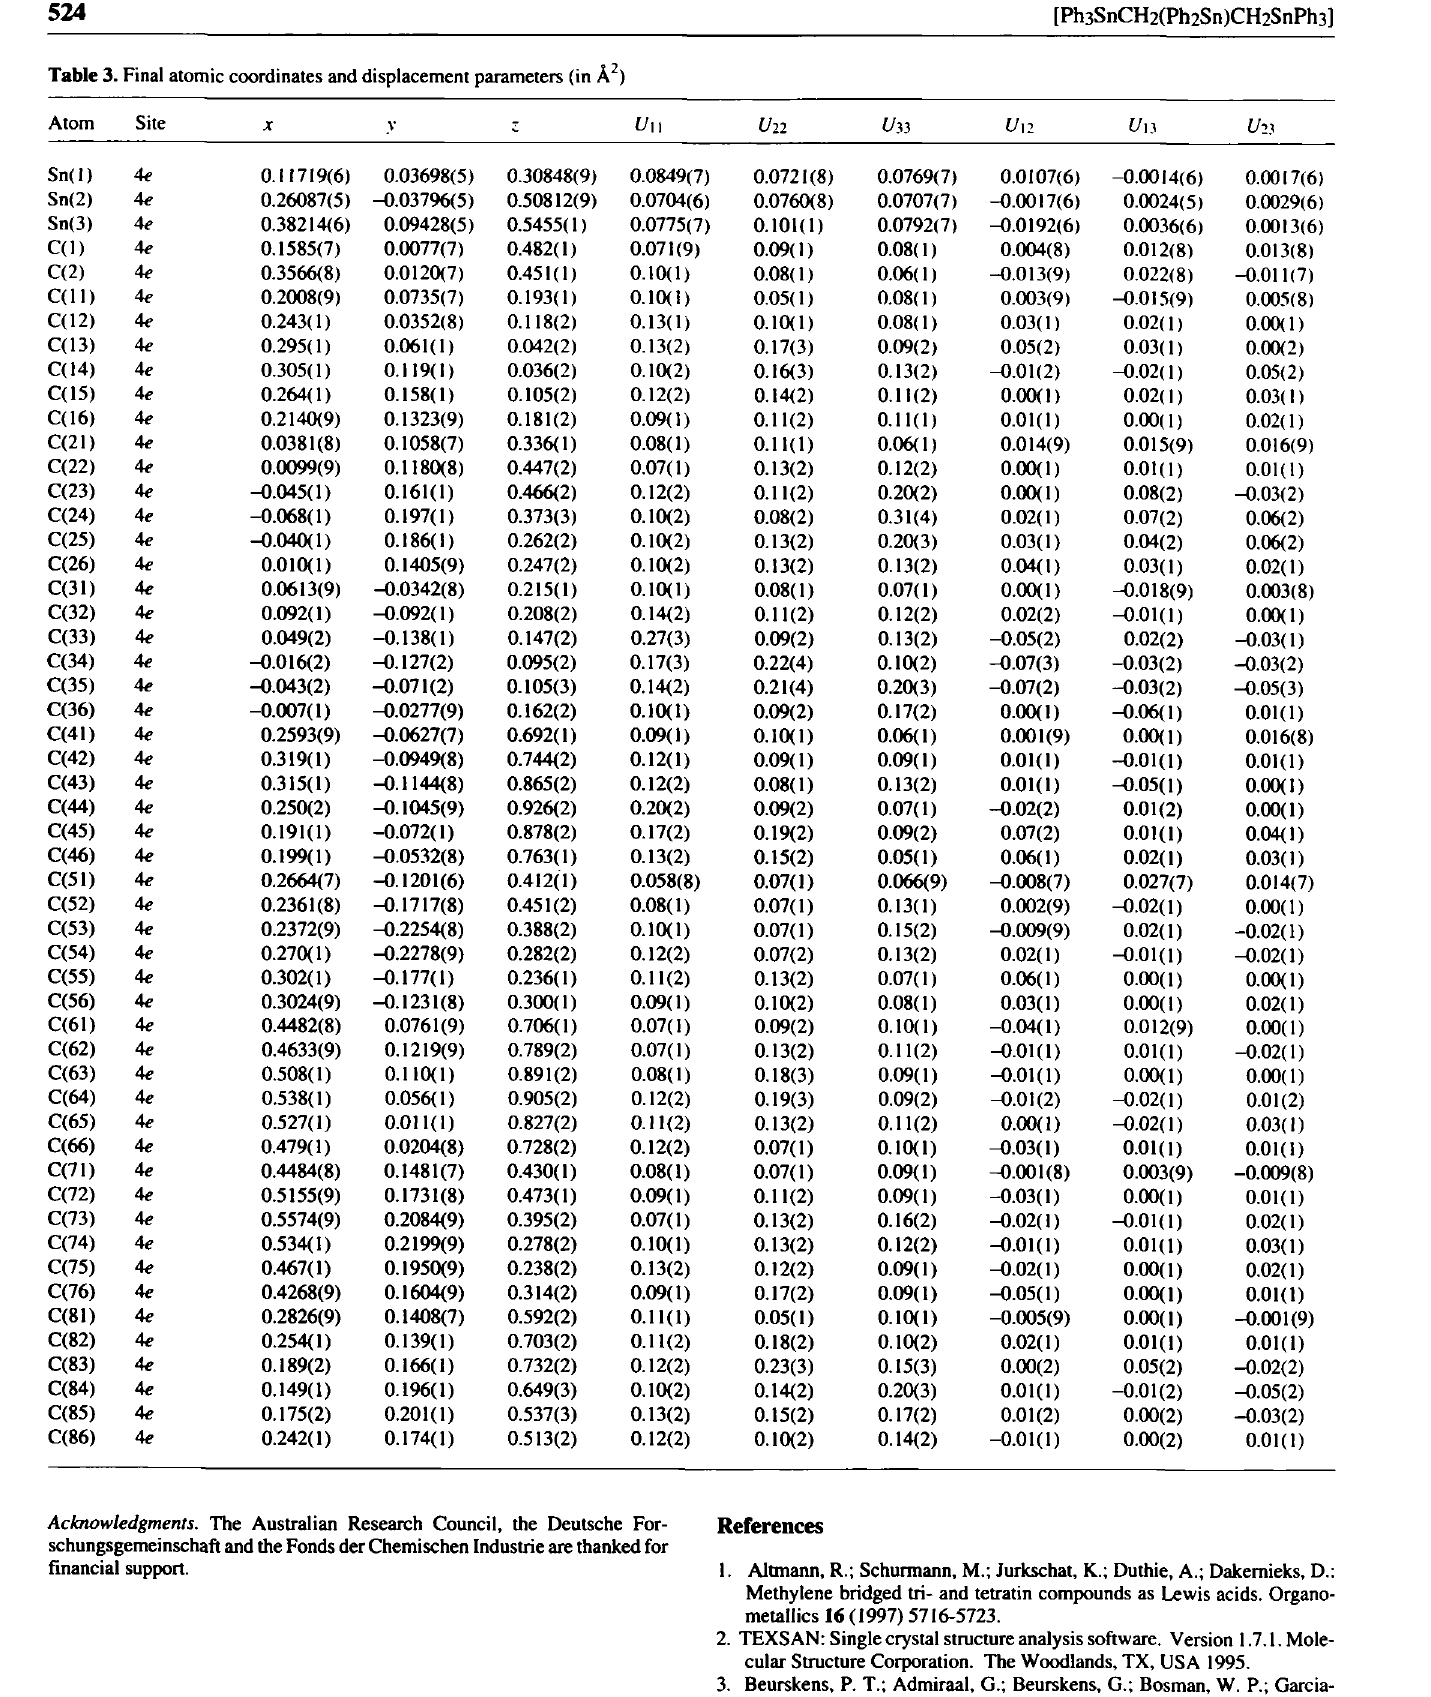
Table 3. Final atomic coordinates and displacement parameters (in Â^) Atom